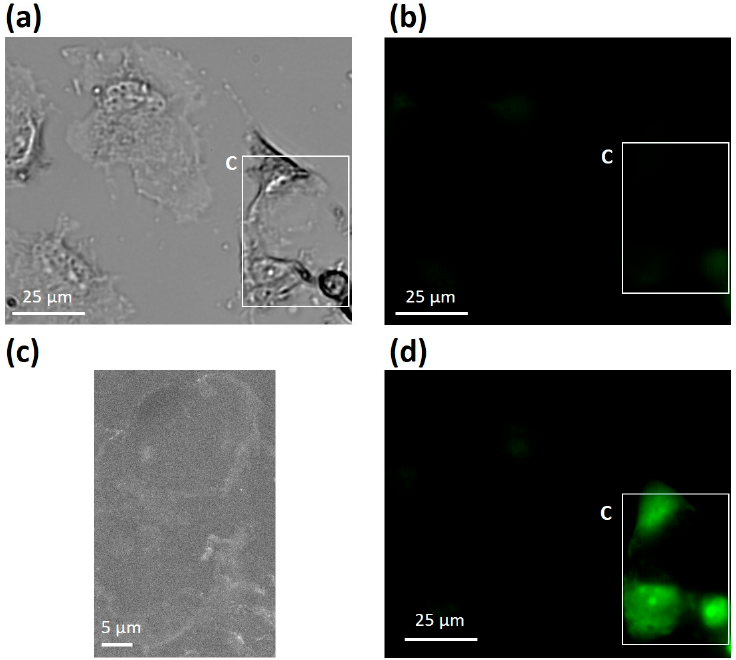
Figure 5. Fluorescence of fixed and reduced COS-7 cells before and after electron beam-induced EFP labeling for a new correlative light-electron microscopy (CLEM). Cells were fixed and reduced in advance. ( a ) Phase contrast microscopy image and ( b ) FM image of the cells before region C was scanned by the electron beam. ( c ) SEM image of the cells present within region C in ( b ). ( d ) FM image of the cells after they were scanned by the electron beam of the inverted SEM. The cells scanned by the electron beam in area C were imaged brighter than the surroundings using FM.